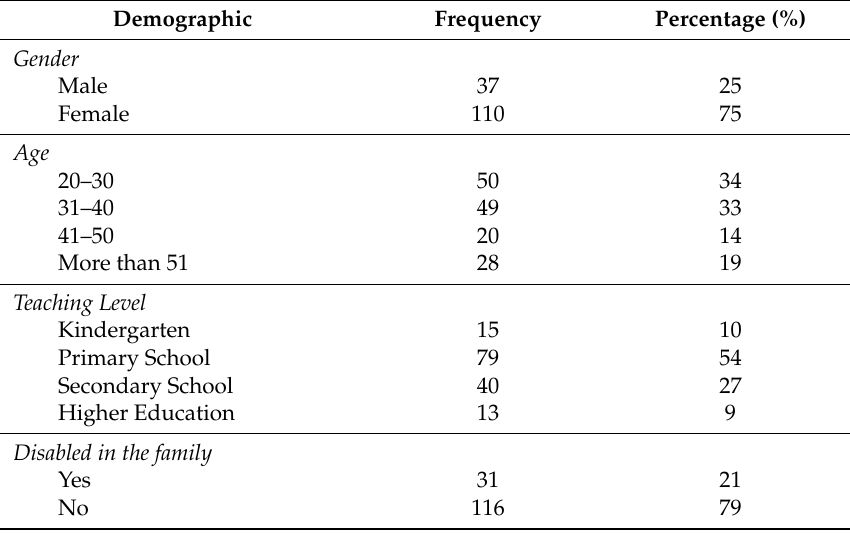
Table 1. Demographic data of the